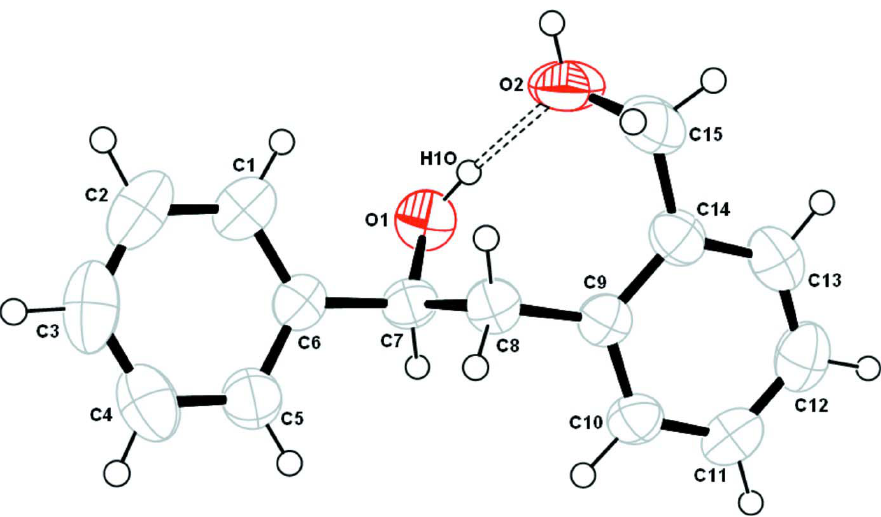
Figure 1 ORTEP diagram of molecule (I) with 50% probability displacement ellipsoids. The dotted lines indicates O—H···O intramolecular hydrogen